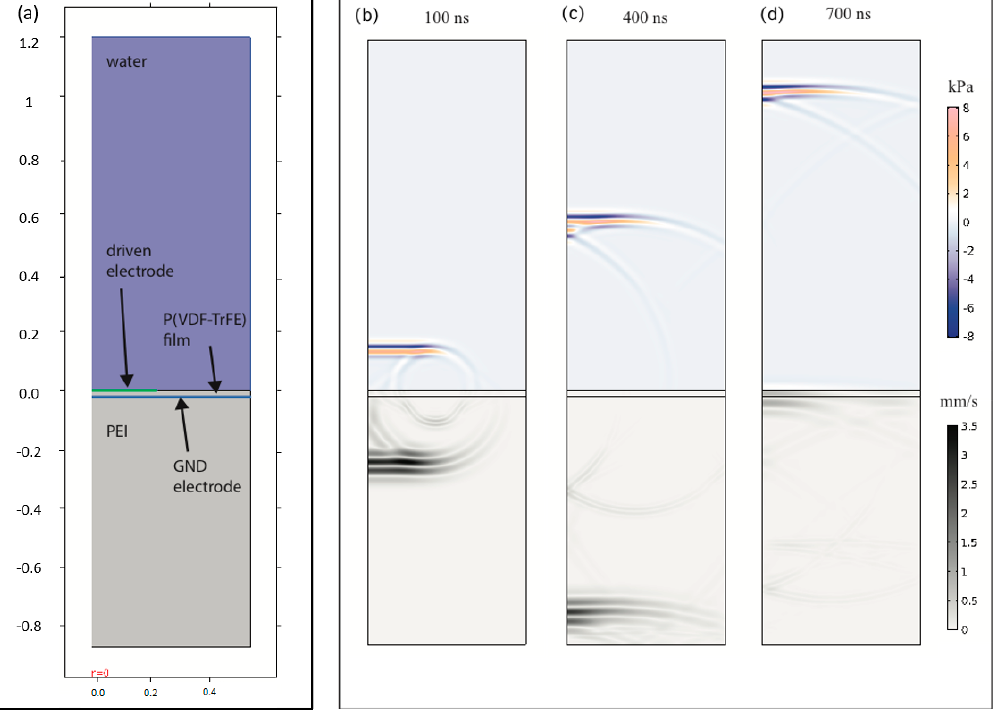
Figure 4. ( a ) Illustration of the computation domain and materials used in COMSOL with the locations of the driven and grounded electrodes shown by the green and blue lines, respectively. Computed pressures (shown in the upper water domain) and wave velocities (shown in the elastic domains) generated from a 0.45 mm electrode diameter of at times ( b ) 100 ns, ( c ) 400 ns, and ( d ) 700 ns after pulse firing.